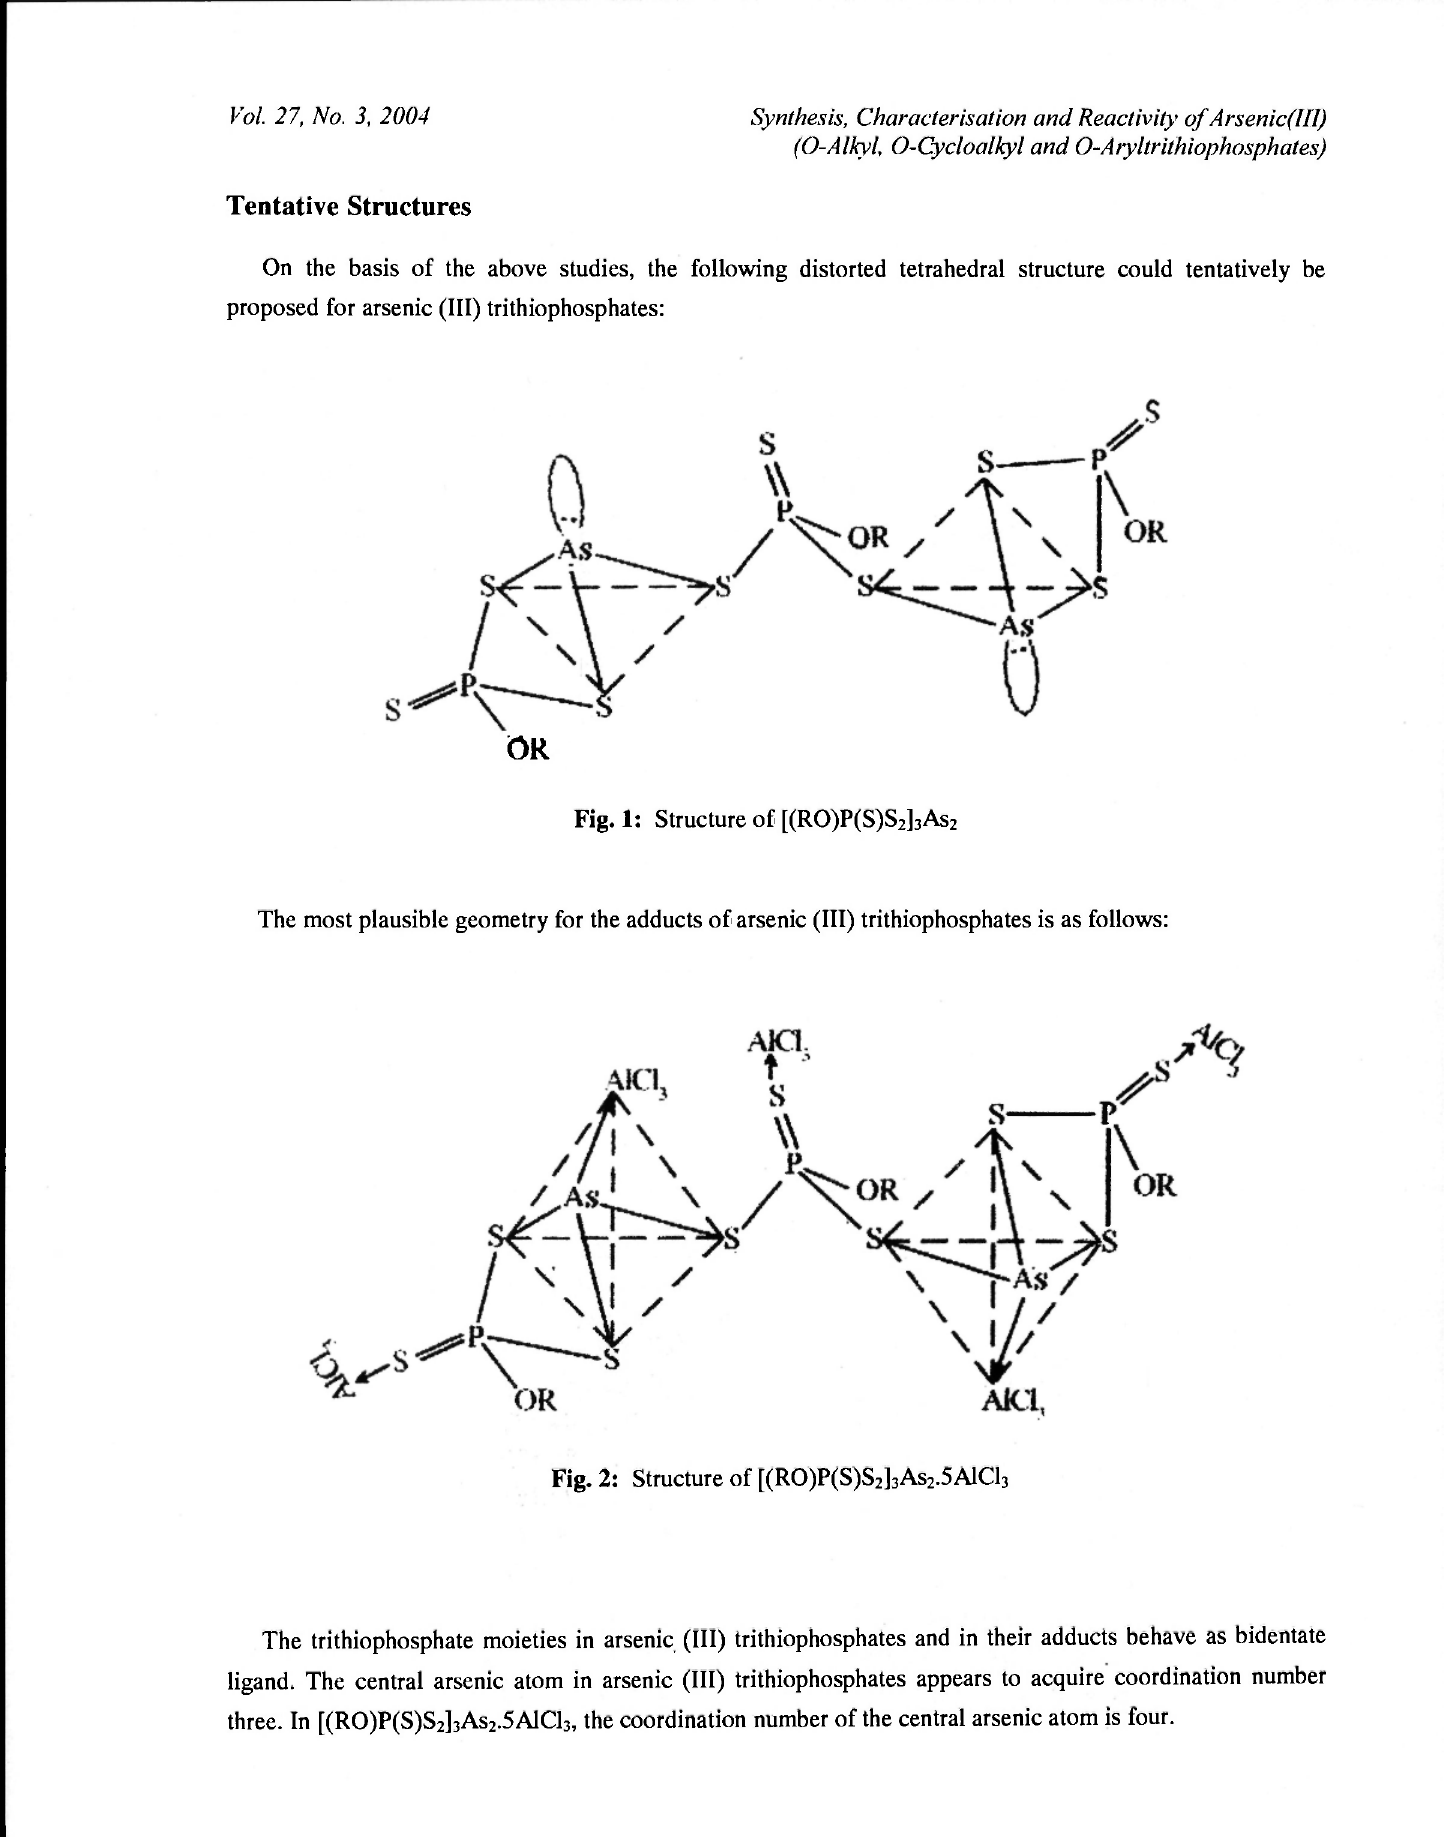
Fig. 2: Structure of [(RO)P(S)S 2 ] 3 AS 2 .5A1C1